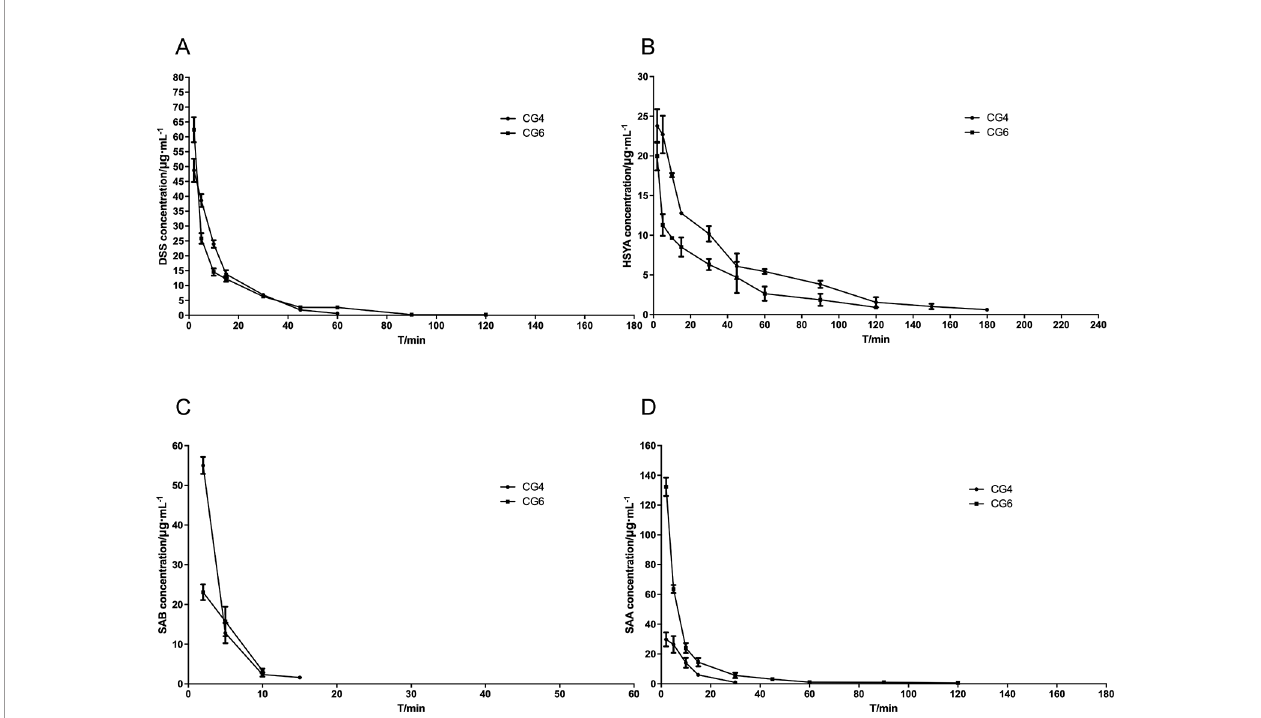
FIGURE 3 | Blood concentrating-time of components. (A) danshensu (DSS); (B) hydroxysaf fl or yellow A (HSYA); (C) salvianolic acid B (SAB); (D) salvianolic acid A